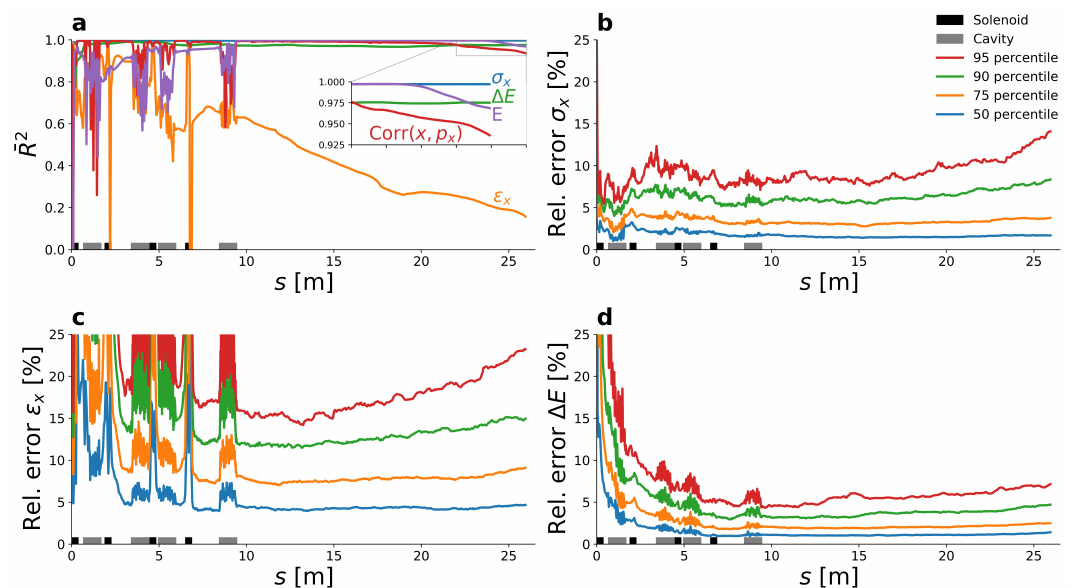
Figure 2. Prediction metrics for the AWA forward surrogate model. The plots show the adjusted coefficient of determination ( a ) and the relative prediction error ( b – d ) as functions of the longitudinal position. All values are calculated on the test set, i.e., on samples that have not been considered when choosing the parameters. We omit the curves for the QOIs in the y direction for the sake of readability because they are close to the ones in x